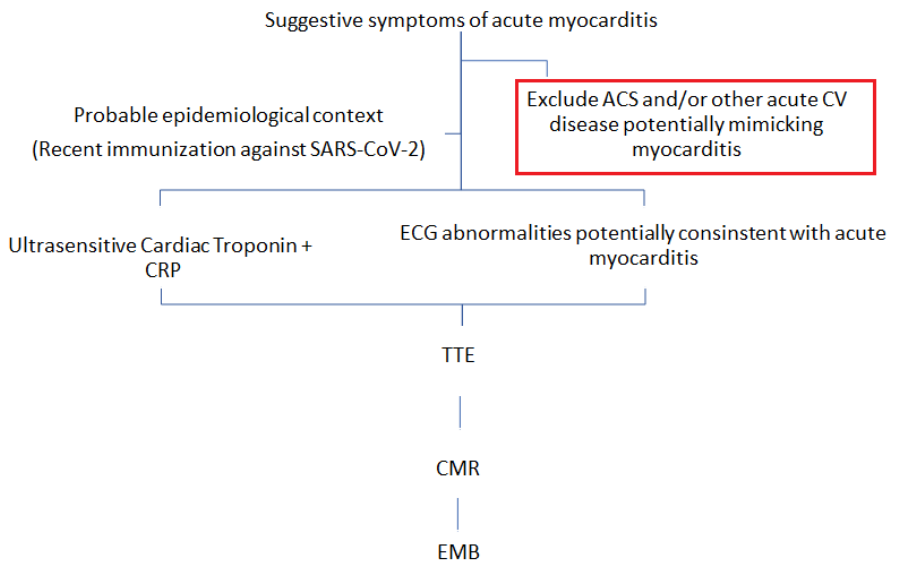
Figure 3. Potential flow chart for the diagnosis of acute myocarditis due to SARS-CoV-2 immunization.CV: cardiovascular disease; ACS: Acute coronary syndrome; CRP: C-reactive protein; TTE: Transthoracic echocardiogram; CMR: Cardiac magnetic resonance; EMB: Endomyocardial biopsy.